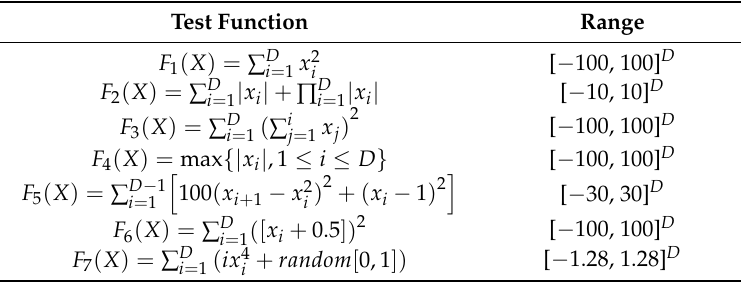
Table 1. Unimodal test functions ( D = 50).